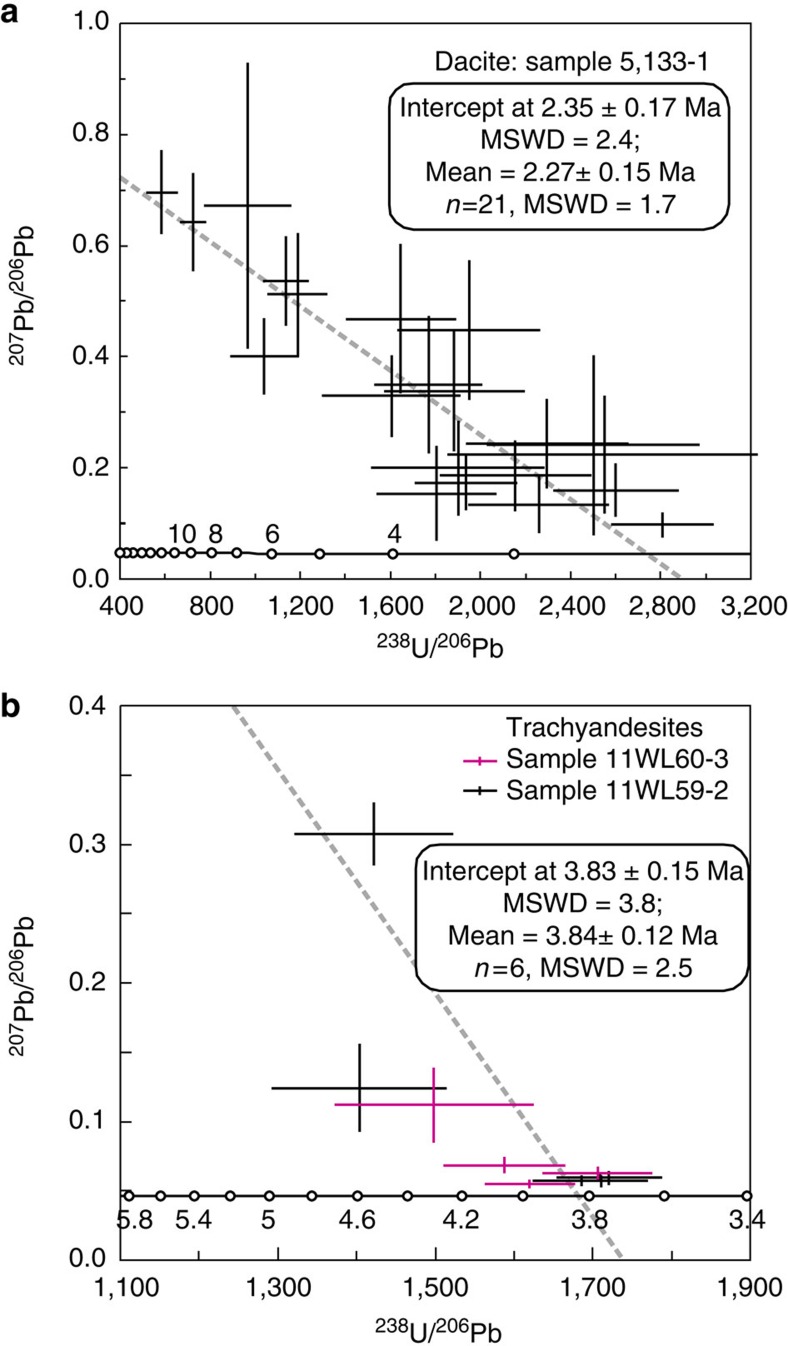
Zircon U-Pb Tera–Wasserburg plots for the zircon analyses.(a) The Dongyue Lake dacite from central-northern Qiangtang lavas. Sample 5133-1 has consistent zircon U-Pb lower intercept (2.35±0.17 Myr ago) and weighted mean (2.27±0.15 Myr ago) ages, indicating an eruption age of ∼2.3 Myr ago. (b) The Wulanwula trachyandesites from central-northern Qiangtang lavas. The red and black error bars are for samples 11WL60-3 and 11WL59-2, respectively. The circles on the horizontal line (part of the Tera–Wasserburg curve) in both a and b represent theoretically defined age scale values (in Myr ago). The analysed spots for two samples from approximately the same area (Supplementary Data set 1) exhibit consistent lower intercept (3.83±0.15 Myr ago) and weighted mean (3.84±0.12 Myr ago) ages, indicating an eruption age of ∼3.8 Myr ago. Error bars for the analytical age data are ‘s.e.'